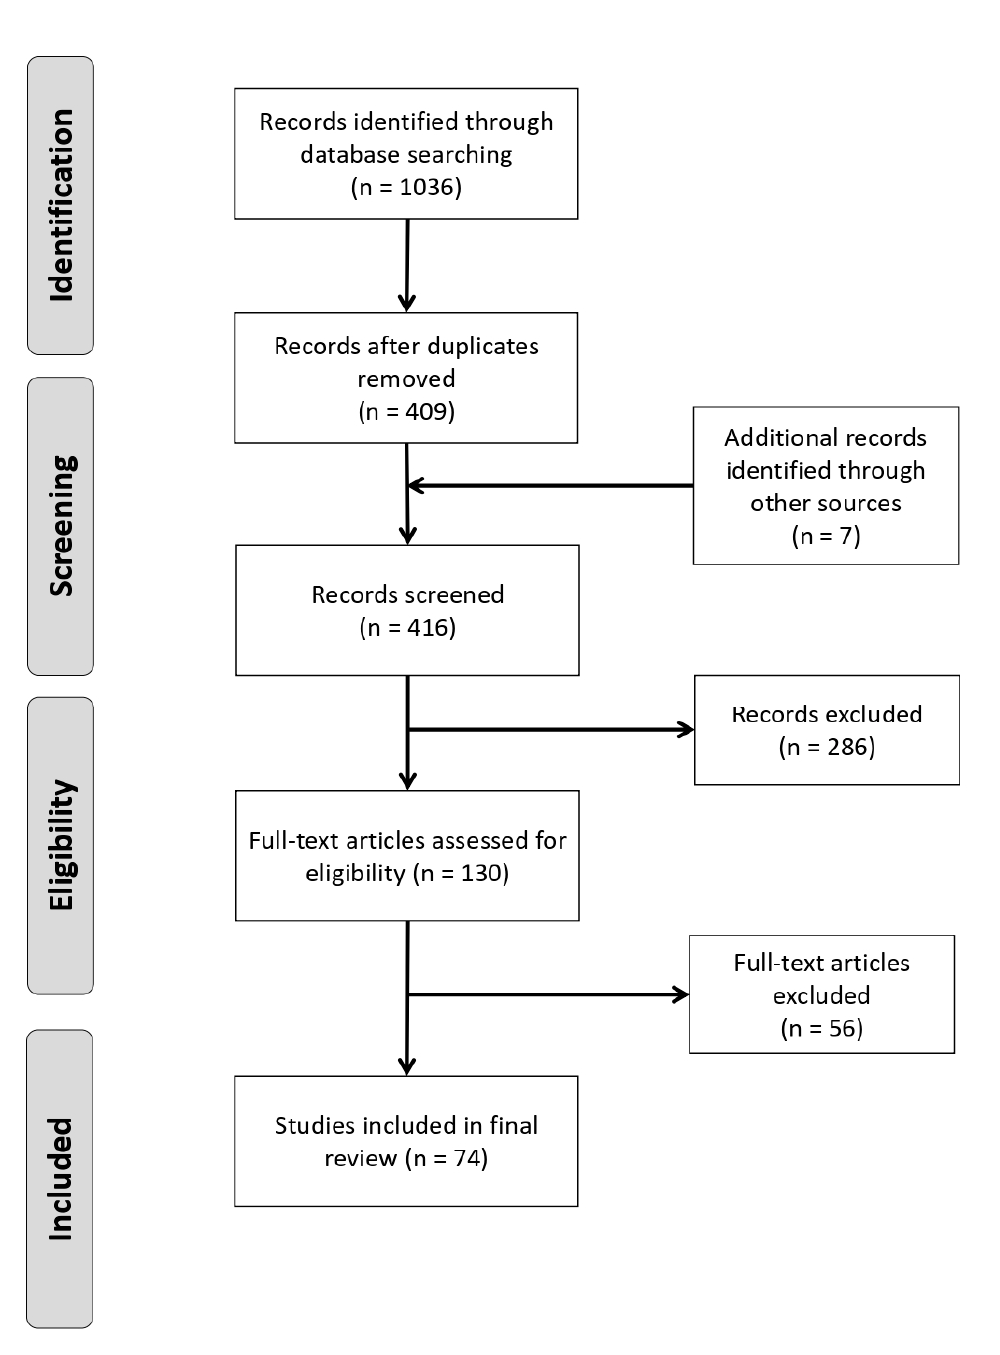
Figure 1. PRISMA flowchart showing numbers of studies at each stage of the review [31].